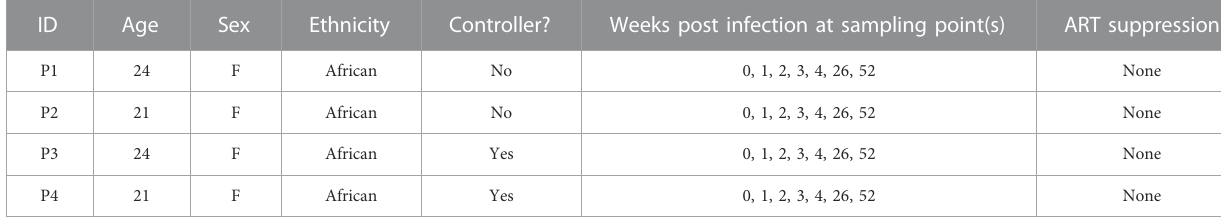
TABLE 2 Characteristics of selected data from HIV + individuals from Kazer et al.